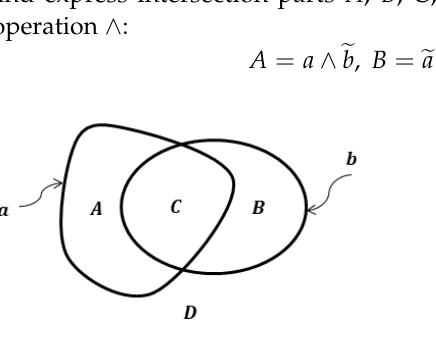
Figure 1. Euler-Venn diagram for the elementary relations between spots.